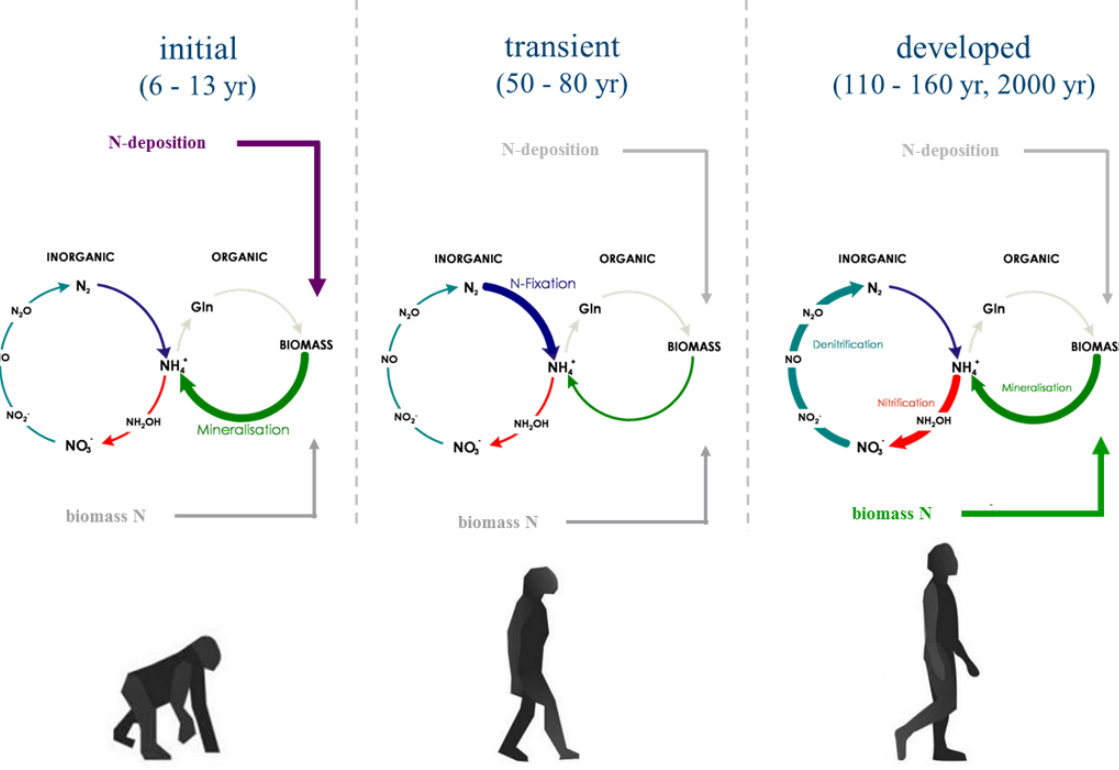
Fig. 2. The development of the microbial N cycle during soil formation. To exclude the strong influence of the increasing biomass along the glacier forefield, underlying data were related to ng DNA to be able to compare results from different development stages. Figure modified after Ollivier et al.